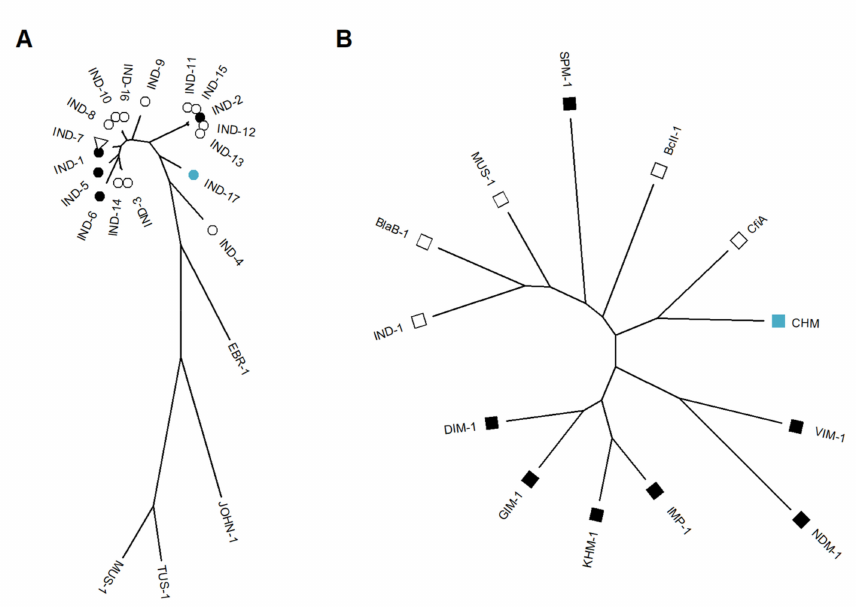
Figure 1. Phylogenetic trees of the identified MBLs. ( A ) Unrooted tree of typical Flavobacteriaceae MBLs [26], including all IND MBL variants. Full circles represent MBLs with determined kinetic properties, empty circles represent variants lacking kinetic data, triangles indicate determined en- zyme structure, and the newly identified IND variant (IND-17) is represented by a full blue circle. ( B ) Unrooted tree of most notable B1 subclass MBLs. Full squares represent plasmid-associated MBLs, empty squares represent chromosome-associated MBLs [27], and the newly identified MBL CHM is identified by a blue